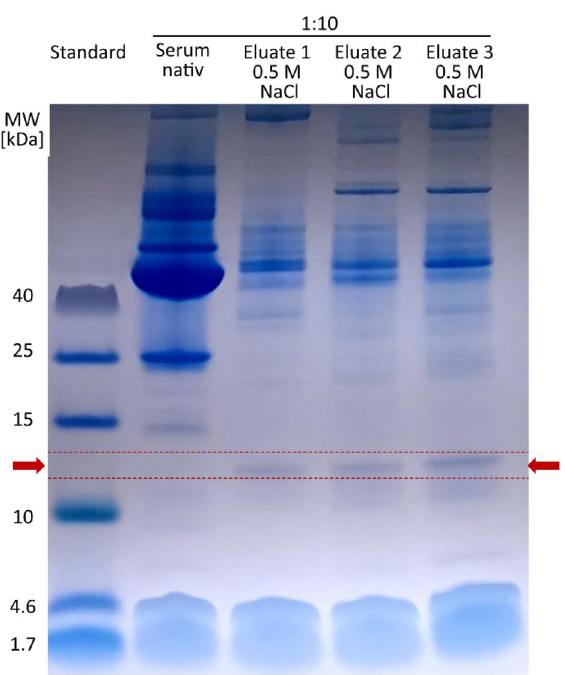
Figure 16. Protein separation of heparin-binding proteins by SDS page. The heparin-binding proteins, which were eluted with 0.5 M NaCl and showed strong endotoxin neutralization, were applied to the gel together with diluted serum. A protein band with a molecular mass between 12 and 13 kDa is only visible in the eluates and marked with red arrows in the